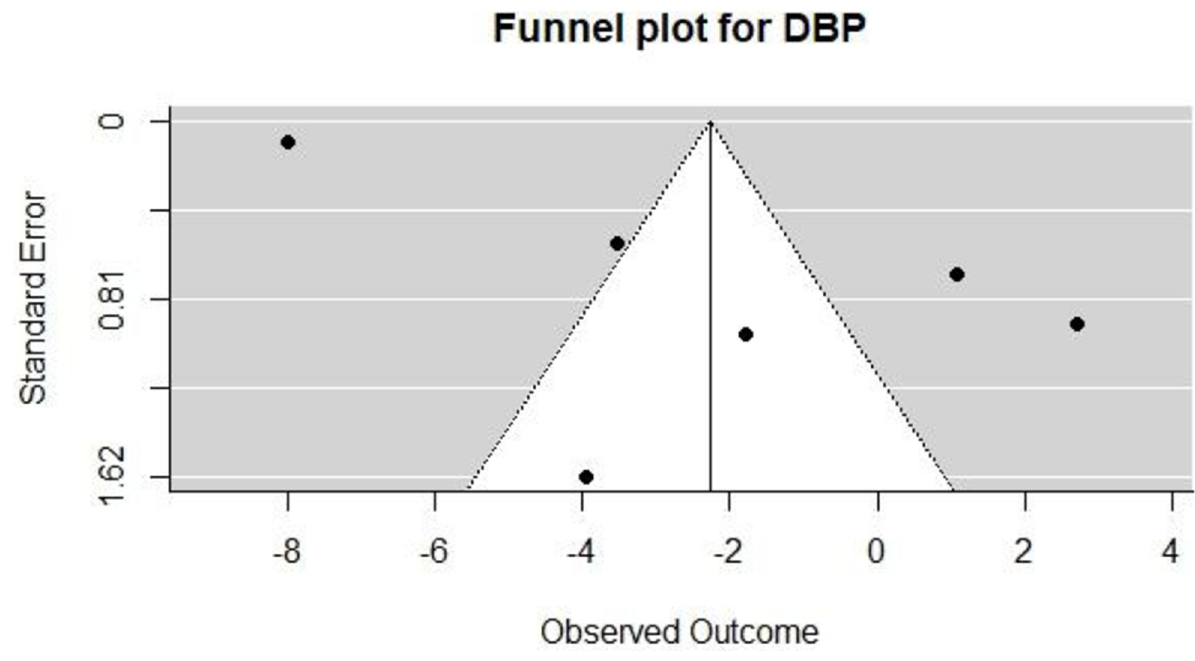
Fig 5. Funnel plot for